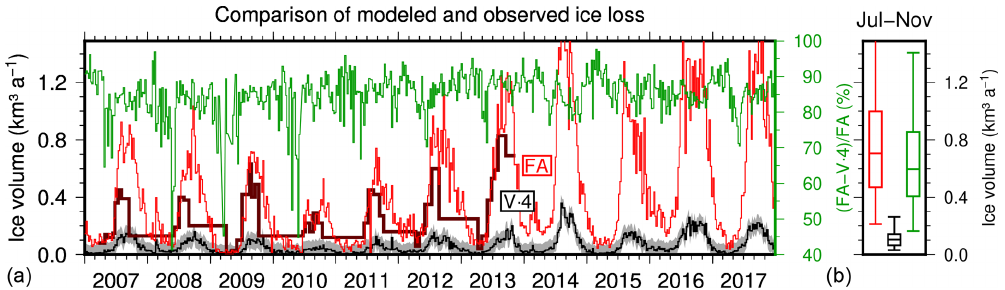
Figure 7. Comparison of frontal ablation (FA) rates at Kronebreen directly measured with satellite remote sensing between 2007 and 2013 (dark red) and modeled in Köhler et al. (2016) from seismic KBS data with weekly resolution (red). Scaled dynamic ice loss rates ( V · 4) modeled in this study from the KBS record and taking into account an average dynamic ice loss detection rate of 25% at KBS are shown in black with gray area indicating uncertainty (2 times the standard deviation estimated in the 2016 calibration period, Table 1). The green curve is the percentage of total frontal ablation not explained by modeled dynamic ice loss. Panel (b) shows box plots for calving season (2%, 25%, 98%, and 75% quantiles) using difference (FA-4 · V ) instead of